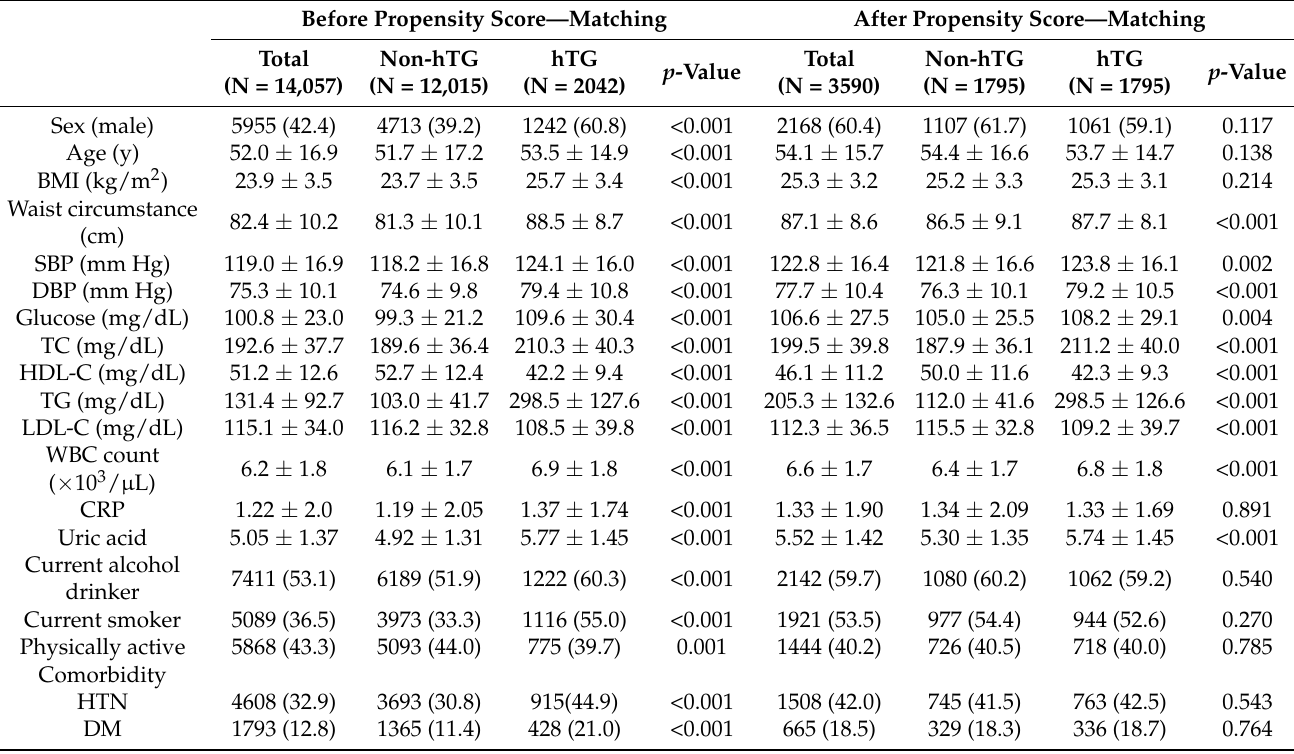
Table 3. Clinical characteristics of study population according to the presence of hypertriglyceridemia. Before Propensity Score—Matching